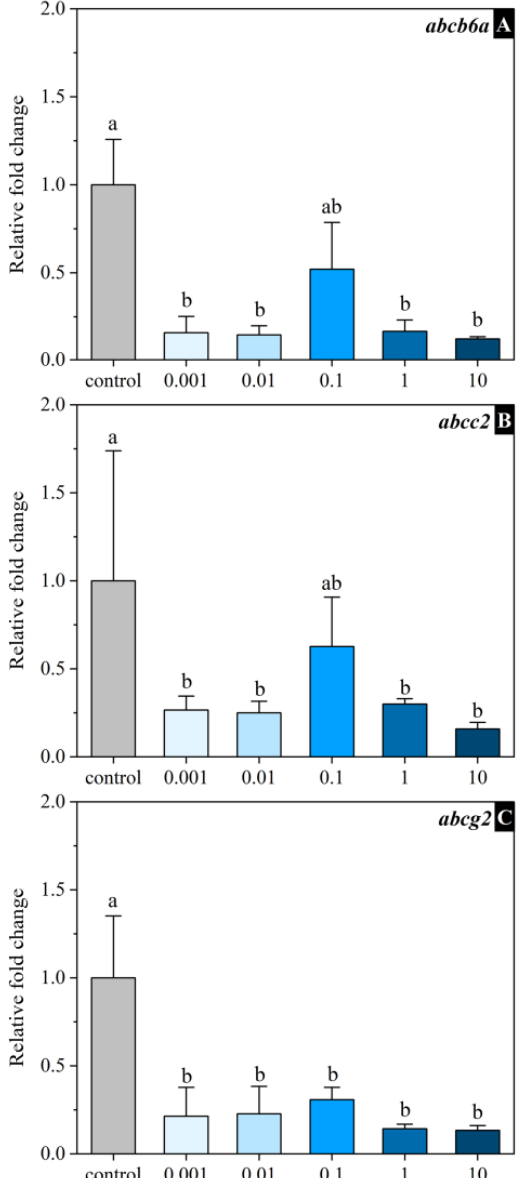
Figure 4. The relative fold change of mRNA expression of ( A ) abcb6a , ( B ) abcc2 , and ( C ) abcg2 in 12 dpf medaka larvae exposed to control and 0.001–10 µ g/mL of polystyrene nanoplastics. abcb6a belongs to P-gp transporter genes, abcc2 and abcg2 belong to MRP transporter genes. Treatments sharing the same lowercase letters are statistically similar to each other (one-way ANOVA, Tukey’s post hoc, p < 0.05).